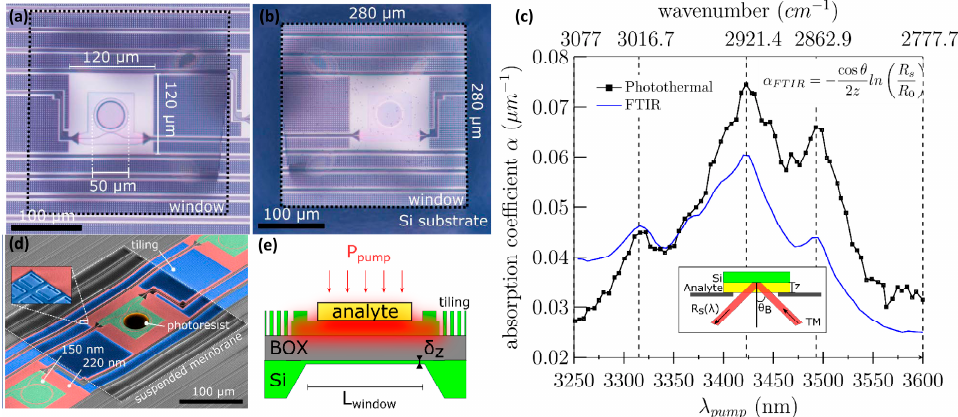
Figure 16. Microscope image of the SOI MRR suspended on BOX membrane with AZ5214 photoresist as mock-up analyte: ( a ) top and ( b ) bottom view; ( c ) The measured photo-thermal signal is scaled to calculate the absorption coefficient of the analyte and is compared to FTIR measurement. The FTIR signal is collected in reflection at the Brewster angle and TM polarization and is used with the formula in the inset to estimate the absorption coefficient; ( d ) A tilted SEM image with false coloring shows the